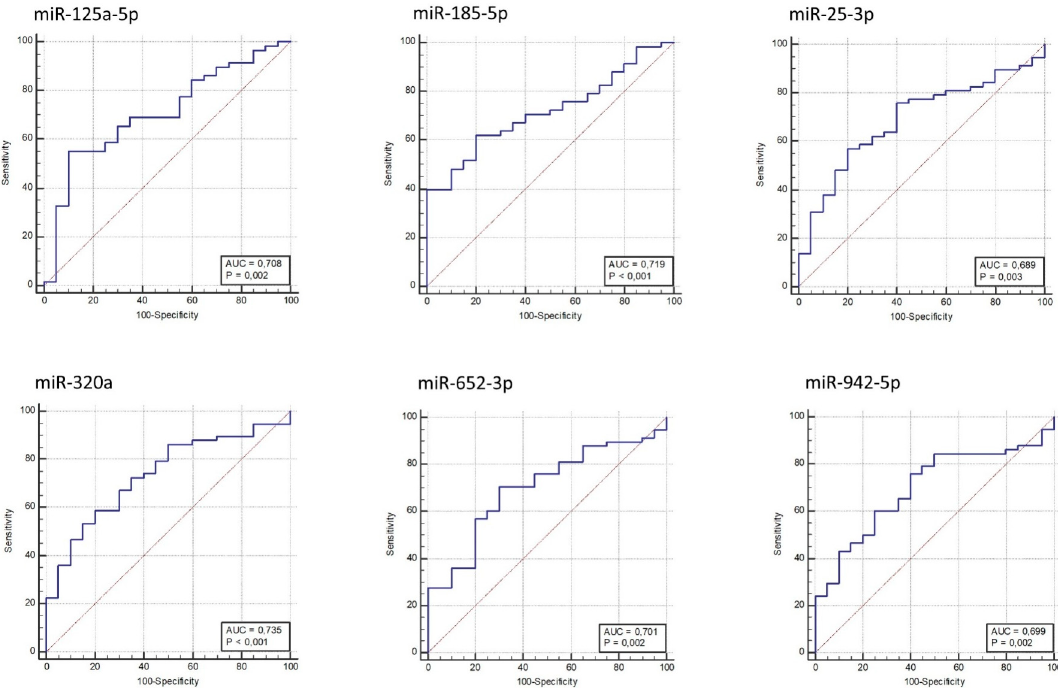
Figure 2. Receiver operating characteristic (ROC) curves for MS versus HC based on miRNAs relative expression data. The diagram is a plot of sensitivity (true-positive rate) versus specificity (false-positive rate).